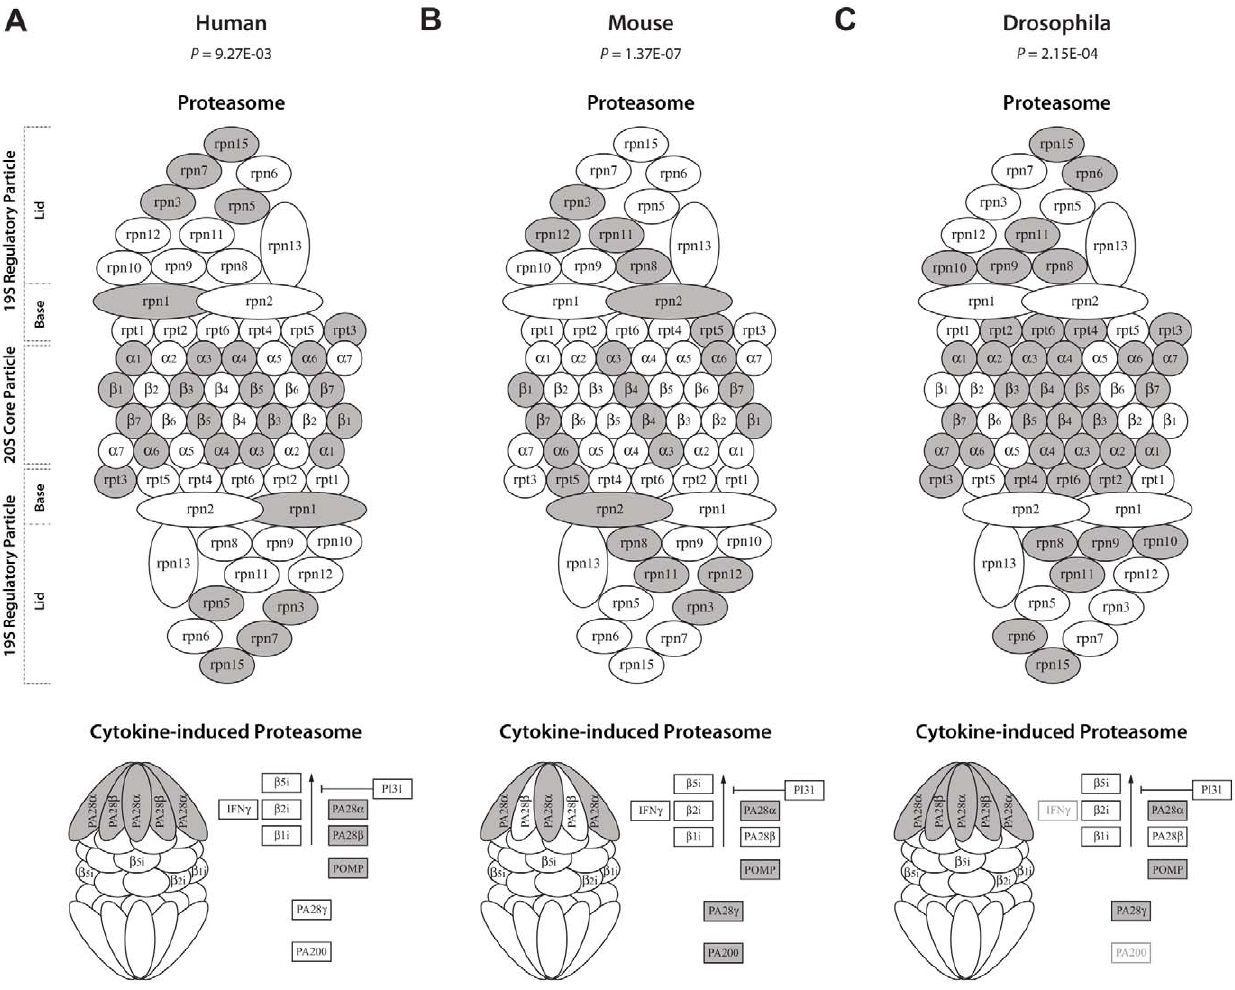
Figure 2. OPMD-deregulation across different subunits of the proteasome in different species. There are widespread differences in gene expression (depicted in dark colors) between OPMD and control in the different functional subunits of proteasome and immunoproteasome in human ( A ), mouse ( B ) and Drosophila ( C ). The Significance of the association between the disease outcome and expression profiles of genes encoding for proteasome and immunoproteasome were previously calculated [19] using the global test [46].